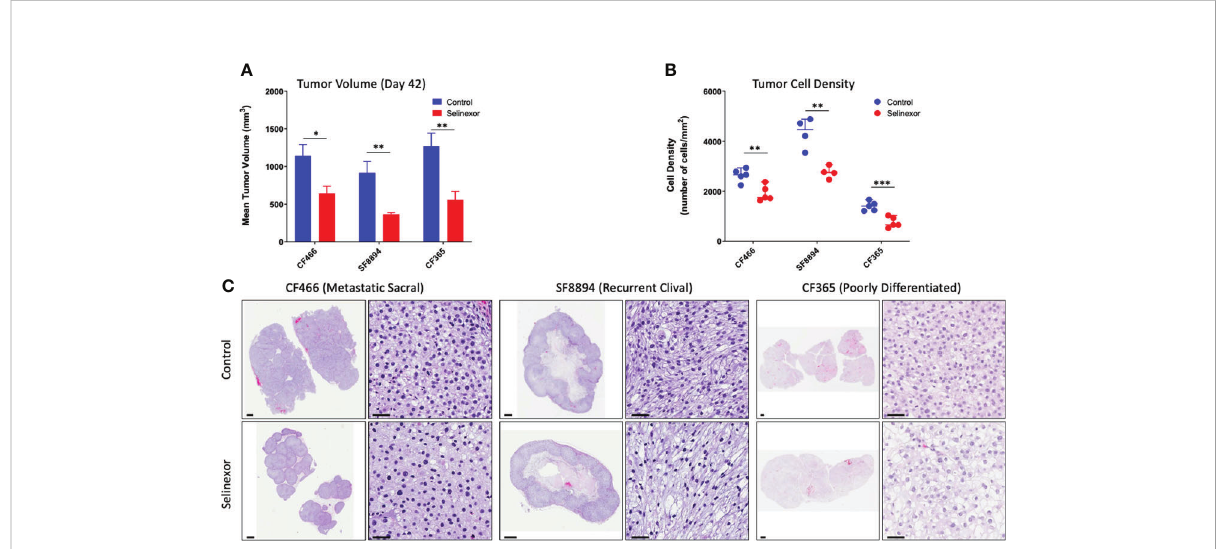
FIGURE 2 Selinexor treatment reduces both tumor size and tumor cell density in three different chordoma preclinical PDX models. (A) Tumor volume at termination of six week treatment; CF466 model, p=0.02, n=5; SF8894 model, p=0.01, n=4; CF365 model, p=0.007, n=5. Data shown as mean +/-SEM. (B) Tumor cell density at termination of six-week treatment, CF466 model, p=0.004, n=5; SF8894 model, p=0.003, n=4; CF365 model, p=0.0009, n=5. Data shown as individual data points, (C) H&E images of indicated tumor models and treatments at low and high magni fi cations with 1 mm and 50 um scale respectively. All P-values calculated using t-tests. *p < 0.05, **p < 0.01, ***p <